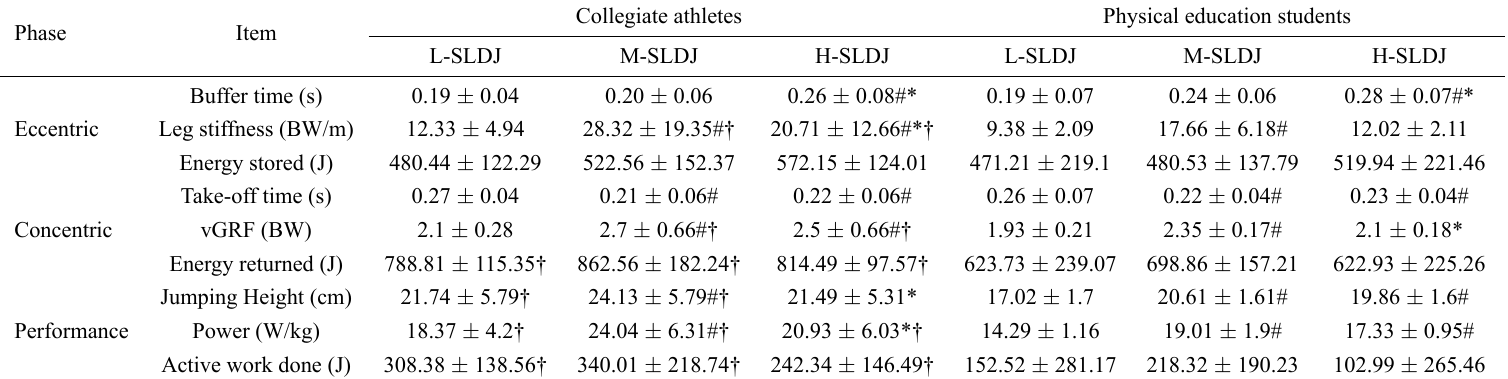
Table 2. Data during the SLDJ testing for male dominant leg with different exercise level.